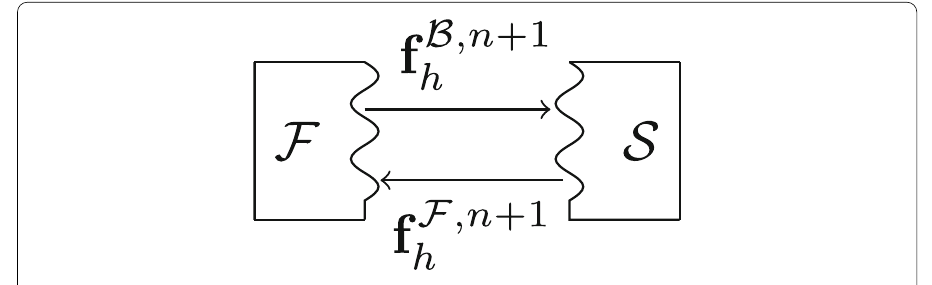
Fig. 6 Depiction of the FSI interaction forces between the fluid field F and the structure field